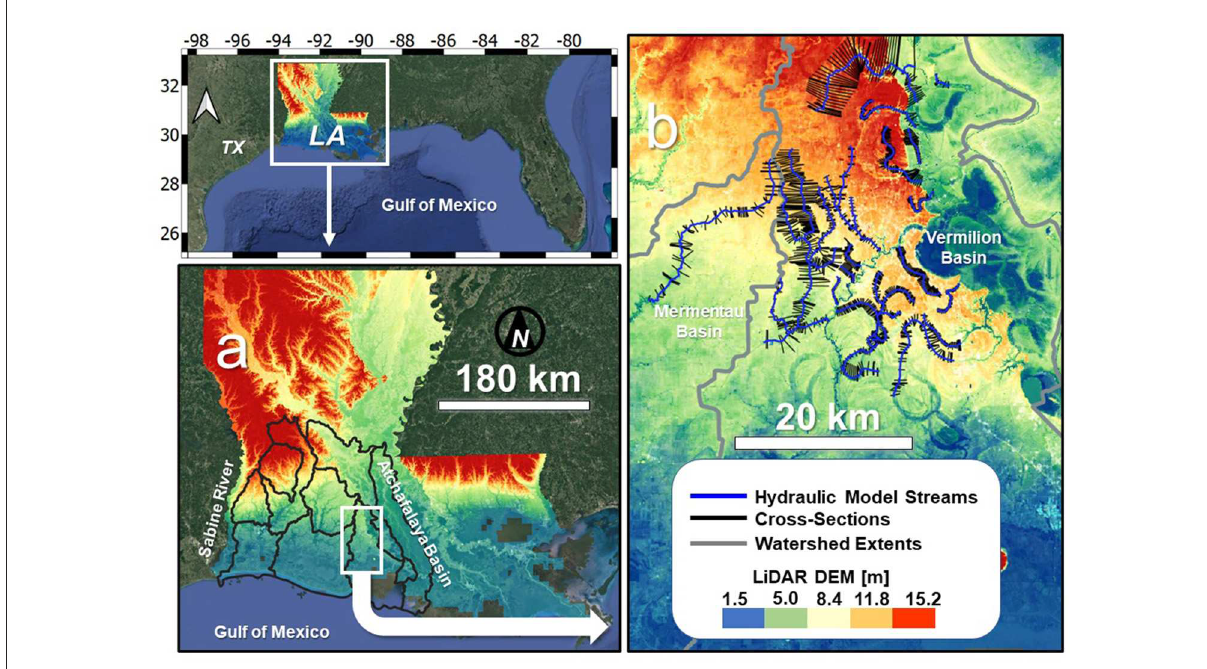
FIGURE1 Location map: (a) hydrologic basins of southwestern Louisiana, (b) HEC-RAS numerical models in the Lafayette, LA primary focus area. The elevation datum is relative to the North American Vertical Datum of 1988 (NAVD 88).